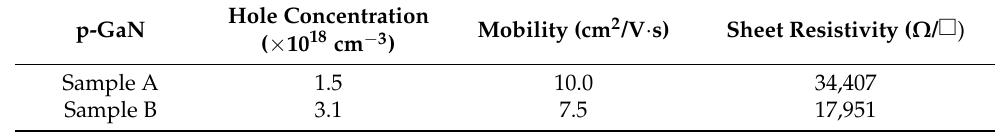
Table 1. Results of the Hall measurement of the samples at room temperature.